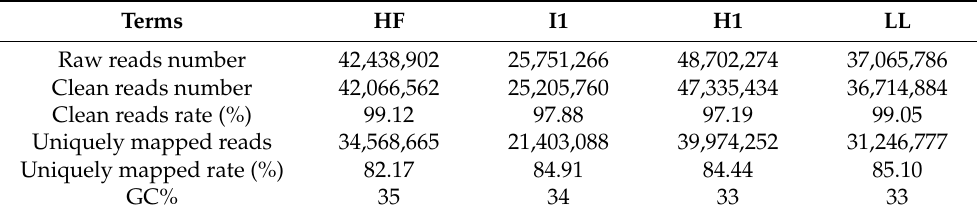
Table 1. Summary of genome-wide methylation sequencing data. HF-healthy Flowering, I1-Phyllody, H1-healthy vegetative and LL-little leaf sesame